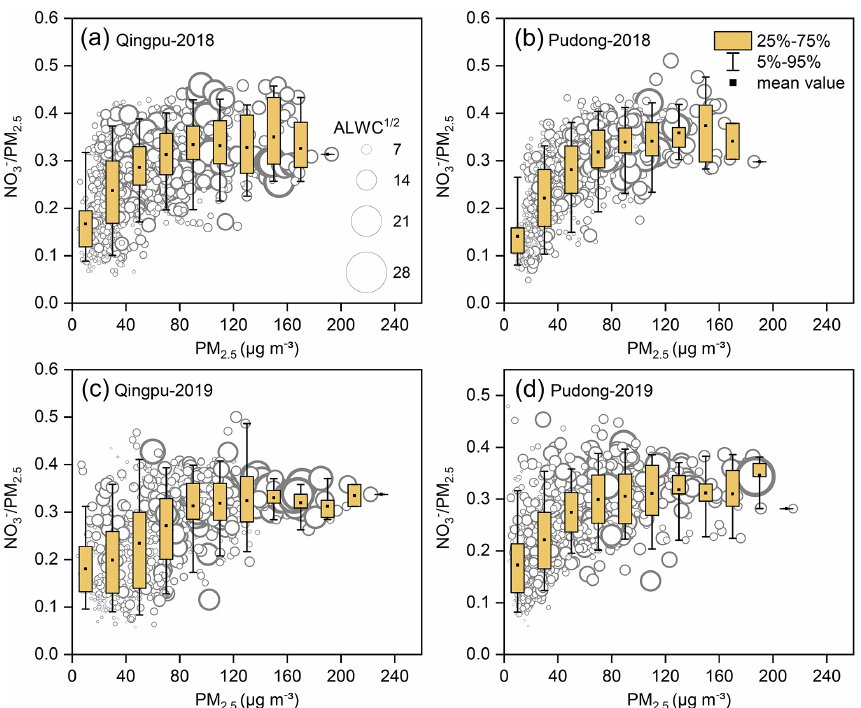
Figure 4. Mass ratio of nitrate to PM 2 . 5 as a function of PM 2 . 5 concentration at (a, c) Qingpu and (b, d) Pudong sites in the winter of 2018 / PM 2 . 5 , and their area is linearly scaled with the square root of and 2019. The circles represent the measured ratio of NO − 3